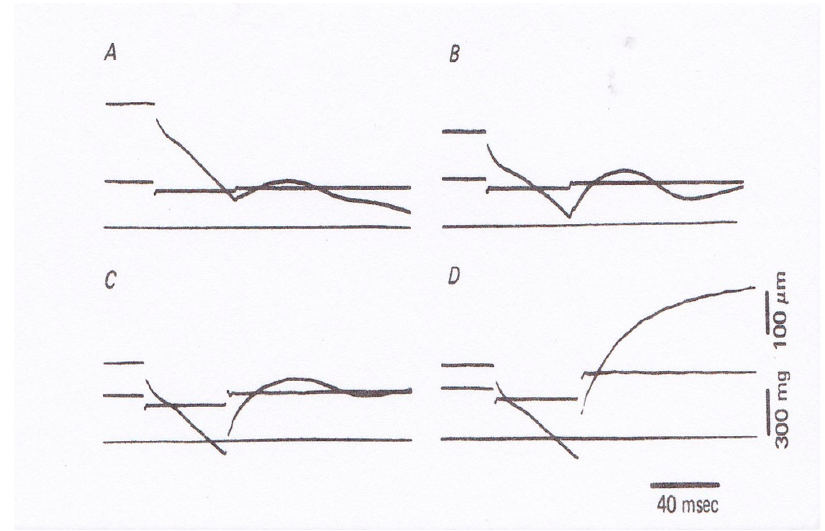
Figure 8. Records of fiber length (upper traces) and force (lower traces) of experiments in which the tetanized intact muscle fiber was first made to shorten isotonically under a load 0.8 Po and, after 50 ms, subjected to quick increases in load from 0.8 Po to 0.85 Po in ( A ) , to 0.9 Po in ( B ), to 1.1 Po in ( C ), and to 1.3 Po in ( D ). Note marked changes in fiber length with alternate lengthening and shortening in ( A – C ). From Ref. [12].